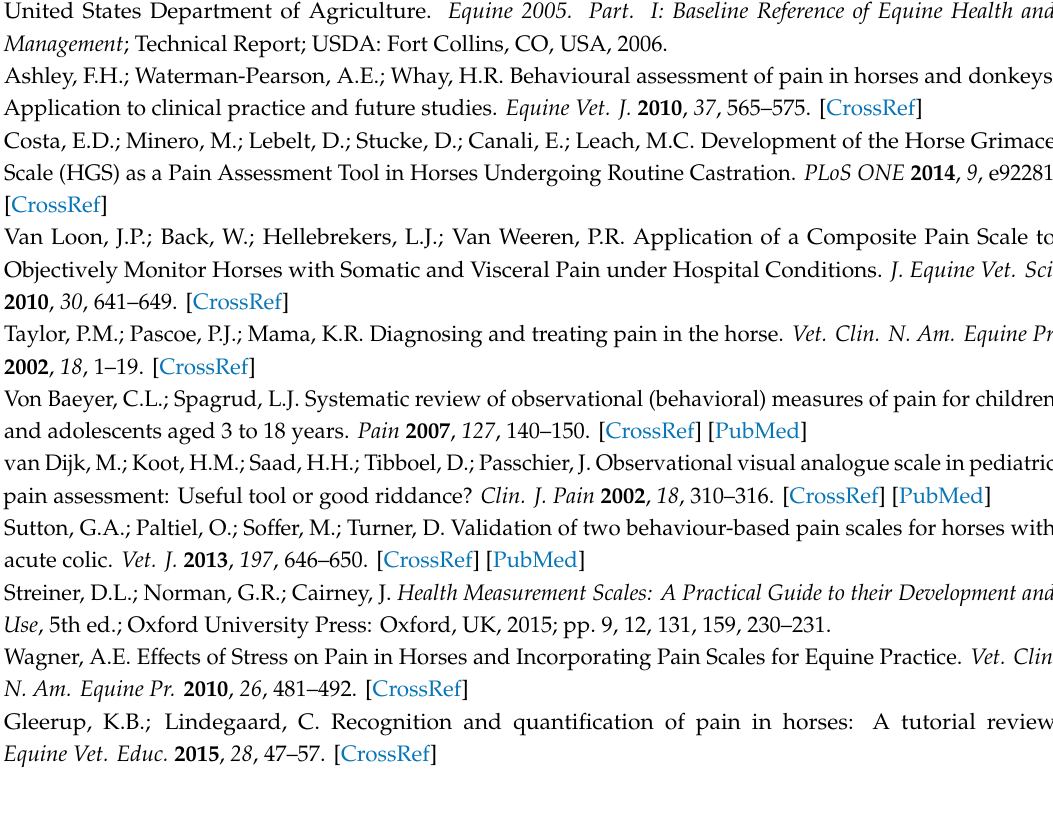
Figure S1: Data collection form—United Kingdom, Figure S2: Data collection